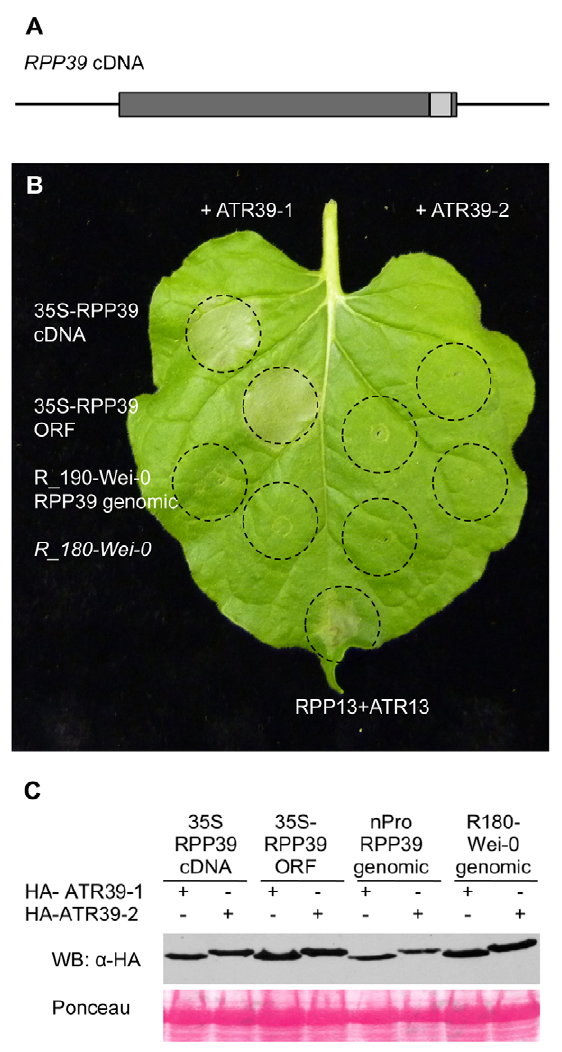
Figure 6. RPP39 cDNA triggers ATR39-1–dependent HR in transient expression assays in Nicotianabenthamiana . A) Gene structure of RPP39 . Promoter and terminator regions are indicated as black lines, exons are shown as dark grey boxes and the intron as a light grey box. B) Agrobacterium -mediated transient expression assay in N. benthamiana . The indicated RPP39 clones and R_180-Wei-0 were inoculated together with HA-ATR39-1 (left) and HA-ATR39-2 (right) at OD 600 nm =0.5 each. Inoculated areas are delineated by dashed lines. The picture was taken 72 hpi. RPP13 co-inoculated with ATR13 Emco5 was included as positive control. C) Protein immunoblot of HA-ATR39 showing similar levels of protein expression. Samples were collected 24 hpi and probed with a -HA antibody. Ponceau staining is included to show equal loading of the samples.